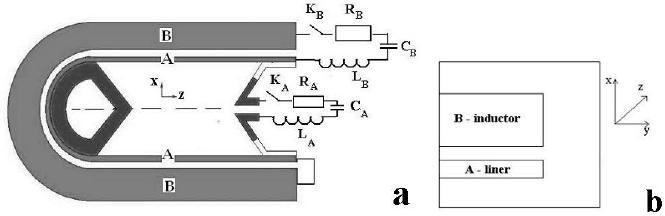
Figure 2. (a) the scheme of the longitudinal section (at the plane y = const ); (b) the scheme of a quarter of the transverse section (at the plane z = const